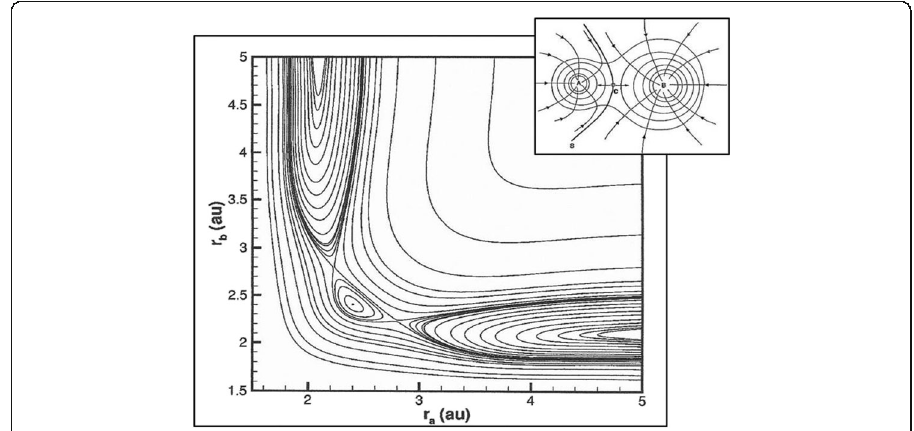
Fig. 20 Potential energy surface of N 2 + N exchange